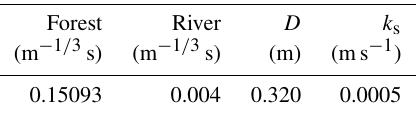
Table 1. Equivalent roughness coefficient of the forest, Manning’s coefficient of the river, and soil-related parameters identified by the radar